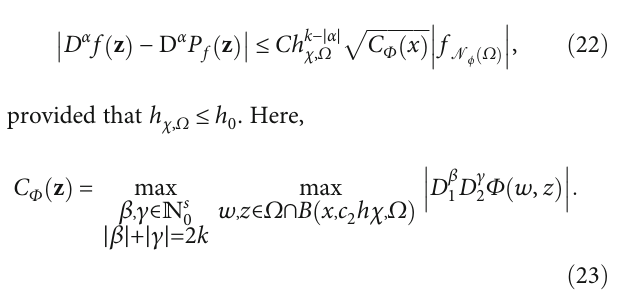
Table 2: Error norms for di ff erent values of α for the Problem 3.